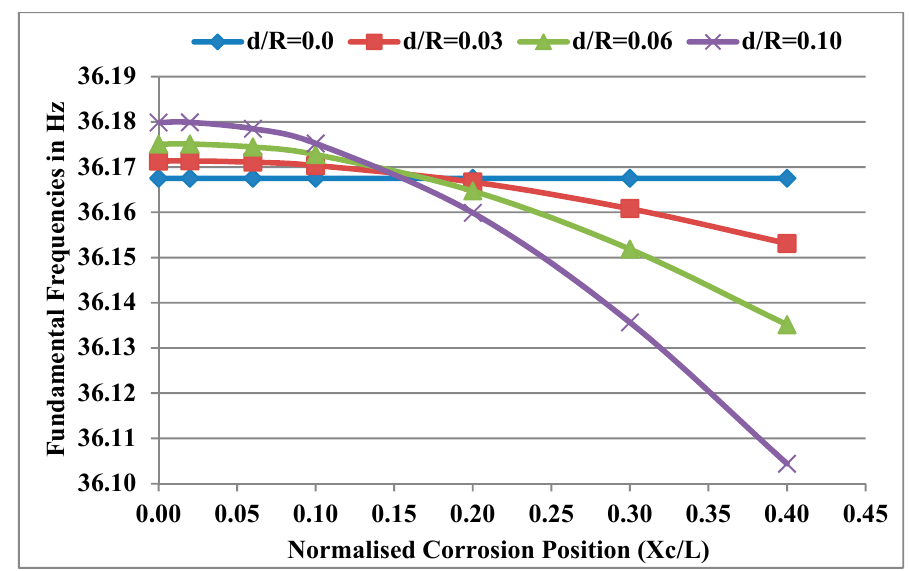
Figure 7. Effect of X c /L for different d/R on the fundamental frequencies of the FG rotor system.